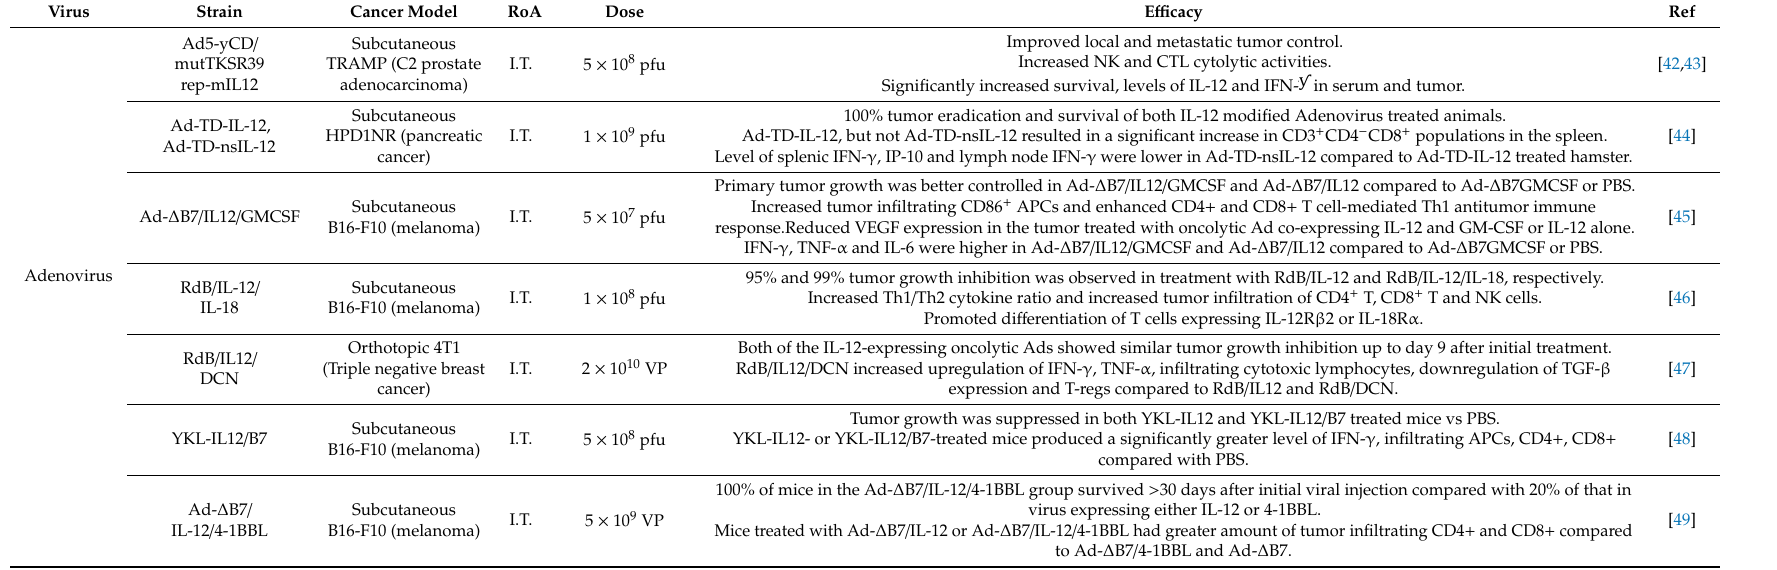
Table 2. List of IL-12 expressing oncolytic viruses (other than OHSVs) and their e ffi cacy in pre-clinical cancer models.